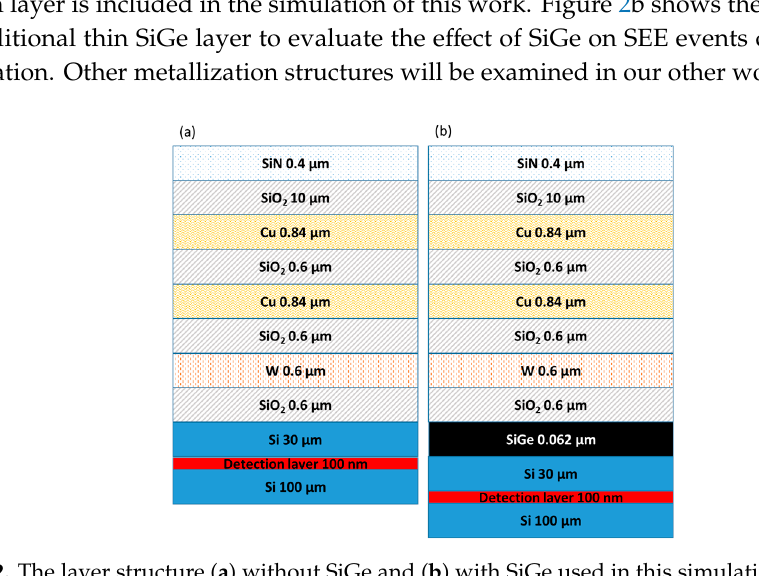
Figure 2. The layer structure (a) without SiGe and (b) with SiGe used in this simulation (not to